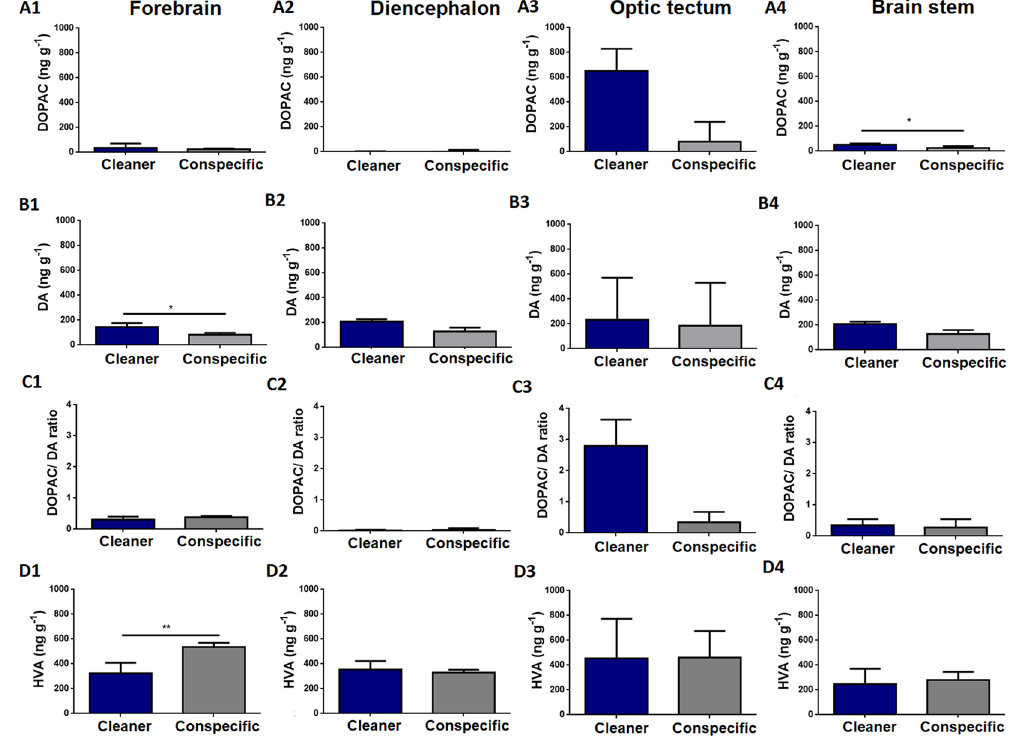
Figure 2. Dopaminergic and HVA levels across clients’ brain areas exposed to a cleaner ( Labroides dimidiatus ) or a conspecific ( Naso elegans ). 3,4-dihydroxyphenylacetic acid (DOPAC) in the (A1) forebrain (FB) area (U = 11; p = 0.1; η 2 = 0.30), (A2) DL area (U = 11; p = 0.08; η 2 = 0.2), (A3) optic tectum (OT) area (U = 10; p = 0.07; η 2 = 0.37), (A4) brain stem (BS) area (U = 8; p = 0.04; η 2 = 0.27). Dopamine (DA) in the (B1) FB area (U = 5; p = 0.01; η 2 = 0.39), (B2) DL area (U = 9; p = 0.05; η 2 = 0.3), (B3) OT area (U = 18; p = 0.45; η 2 < 0.01), (B4) BS area (U = 14; p = 0.2; η 2 = 0.13). DOPAC/DA ratio in the (C1) FB area (U = 15; p = 0.26; η 2 = 0.05), (C2) DL area (U = 8; p = 0.57; η 2 = 0.12), (C3) OT area (U = 15; p = 0.26; η 2 = 0.28), (C4) BS area (U = 17; p = 0.38; η 2 = 0.02). Homovanillic acid (HVA) in the (D1) FB area (U = 1; p < 0.01; η 2 = 0.65), (D2) DL area (U = 13; p = 0.17; η 2 = 0.17), (D3) OT area (U = 21; p = 0.69; η 2 = 0.02), (D4) BS area (U = 20; p = 0.6; η 2 = 0.01). Medians and interquartile ranges are shown. Significant values from Mann-Whitney U tests are shown above bars: * < 0.05, ** <